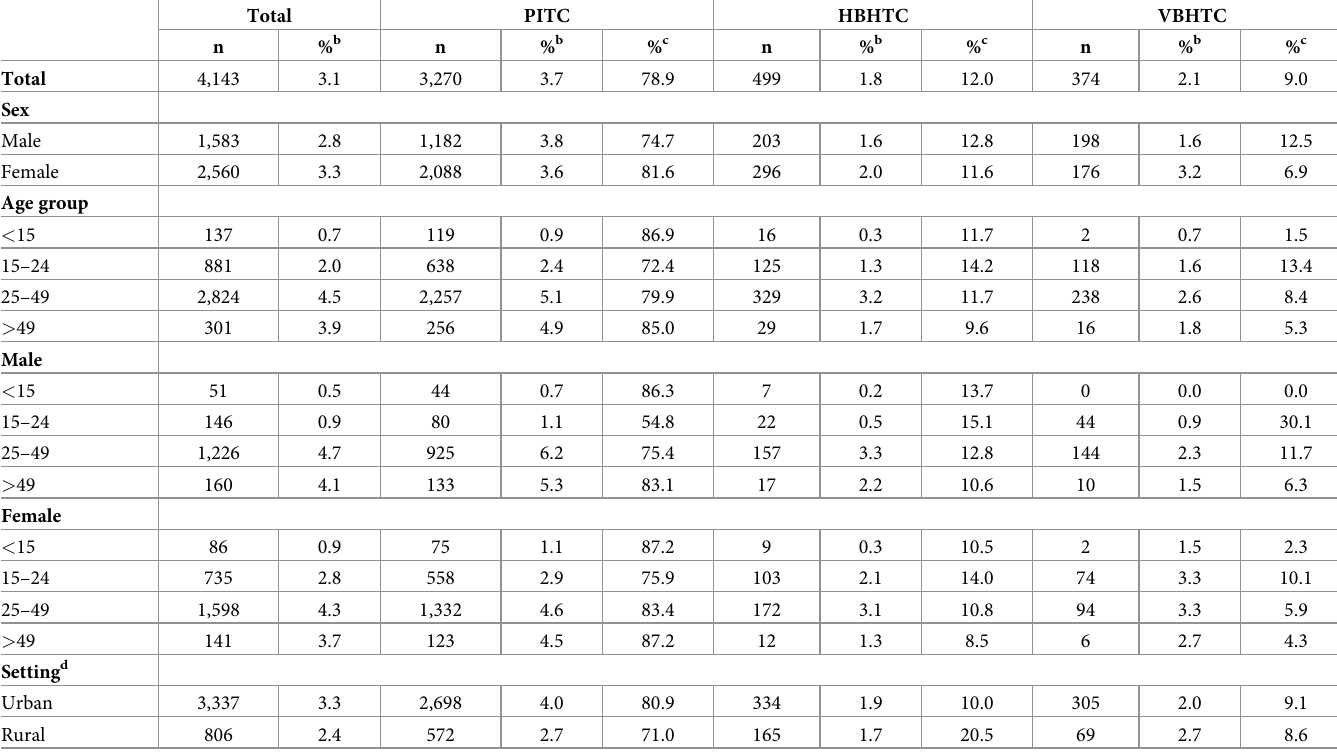
Table 2. New HIV diagnoses, by demographic characteristics and HIV testing strategy, Bukoba Combination Prevention Evaluation, Bukoba Municipal Council, Tanzania, 2014–2017 a